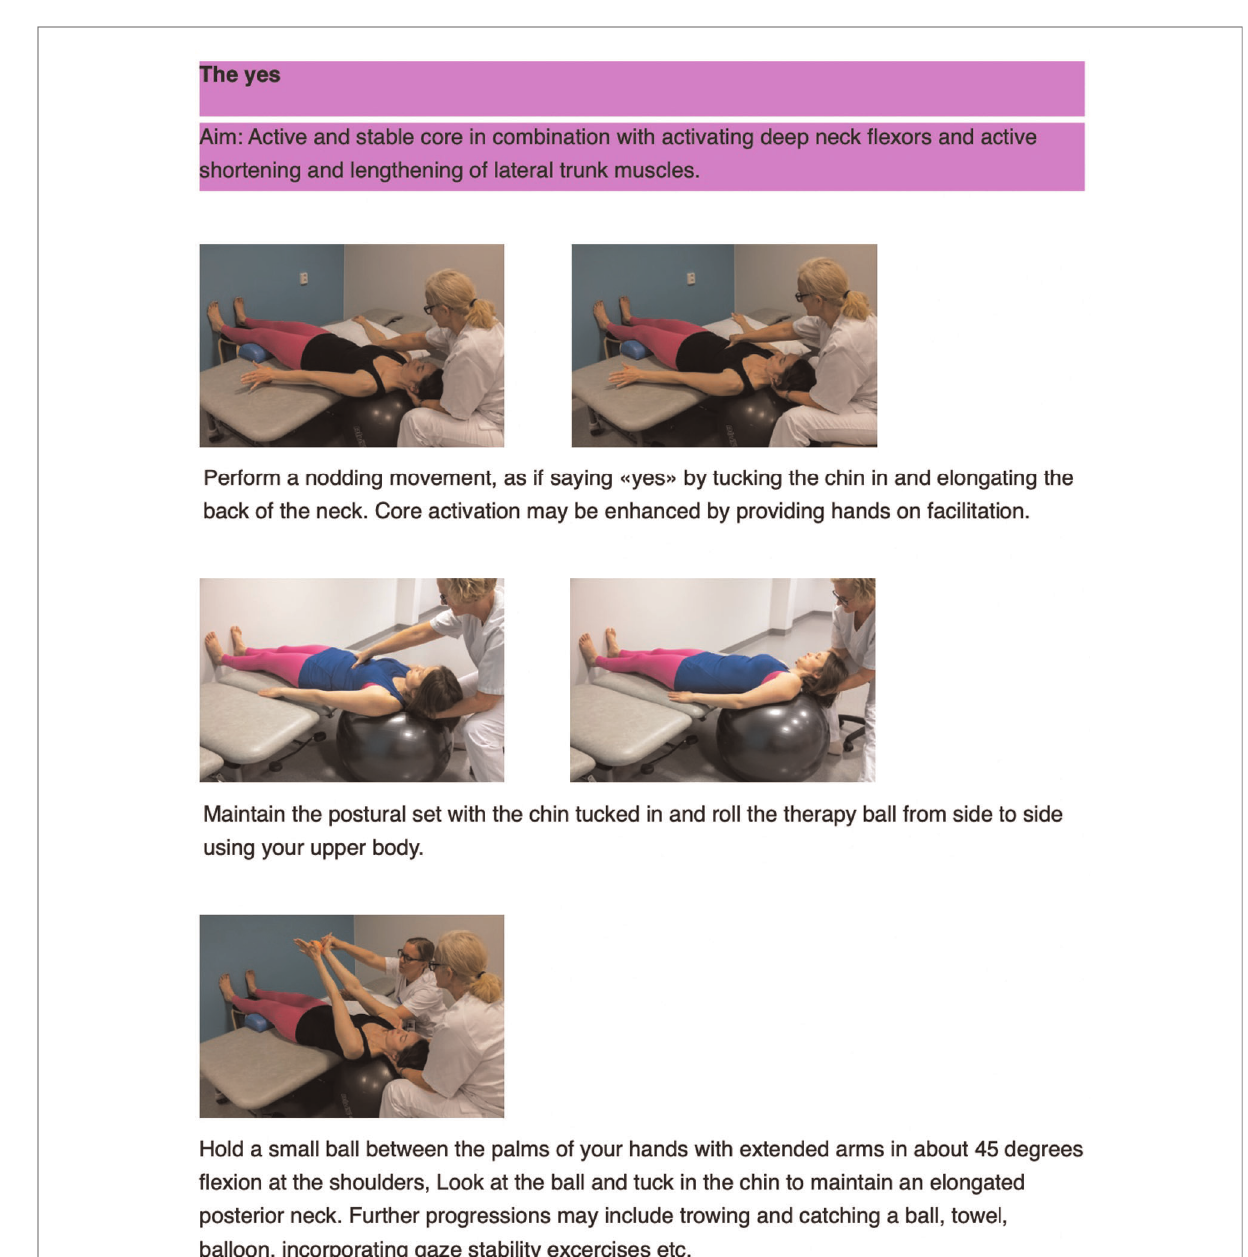
FIGURE 2 Example of exercise aiming for optimal adaptation to the base of support, an active core as well as enhancement of concentric and eccentric mucle activity in the